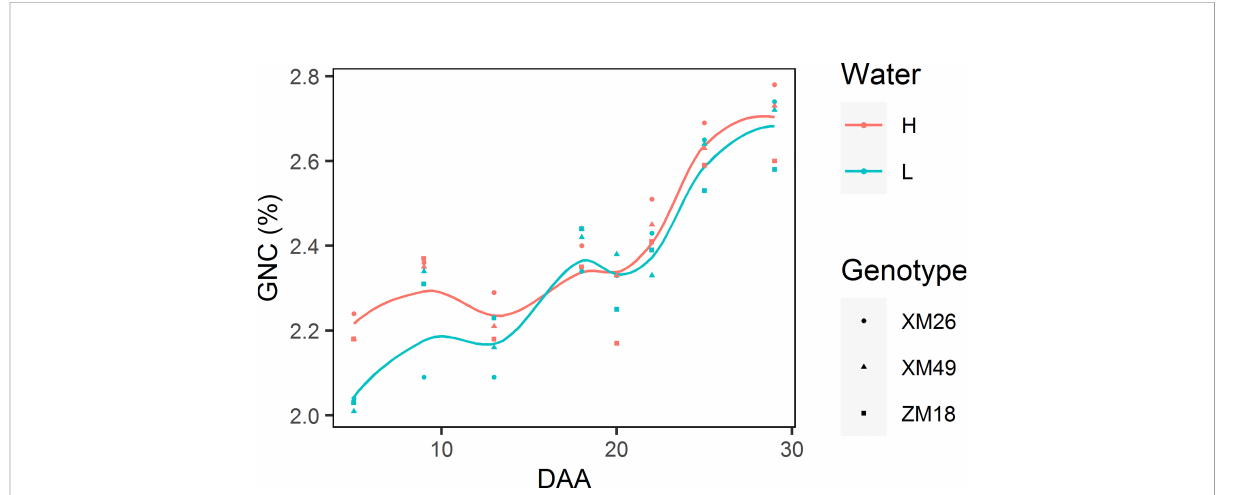
FIGURE 8 Dynamics of grain nitrogen concentration (GNC) of different winter wheat genotypes subjected to two different irrigation treatments. Lines represent values fi tted using the “ loess ” method and the points denote observations. DAA, days after anthesis; H, high-water treatment; L, low- water treatment; XM26, Xinmai-26; XM49, Xinmai-49; ZM18, Zhoumai-18.